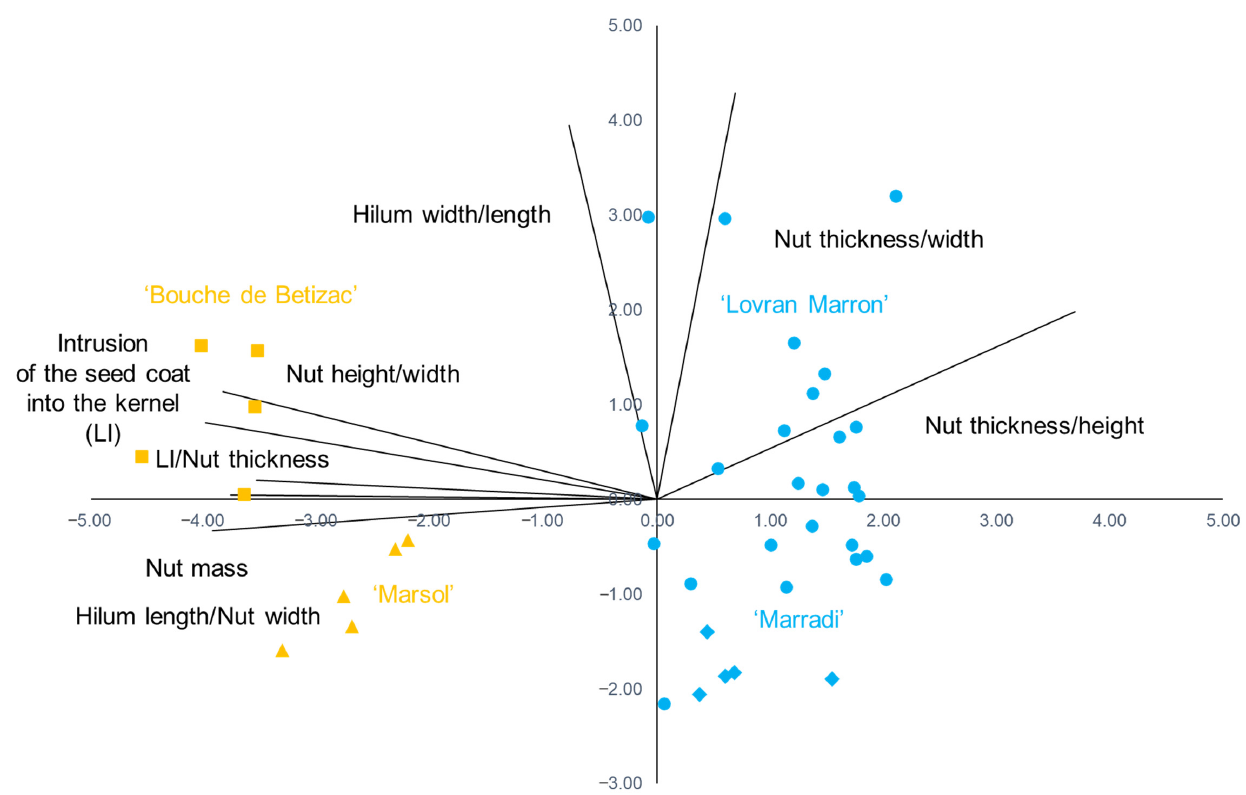
Figure 2. Biplot of the principal component analysis based on eight morphological traits in studied traditional and hybrid chestnut varieties.